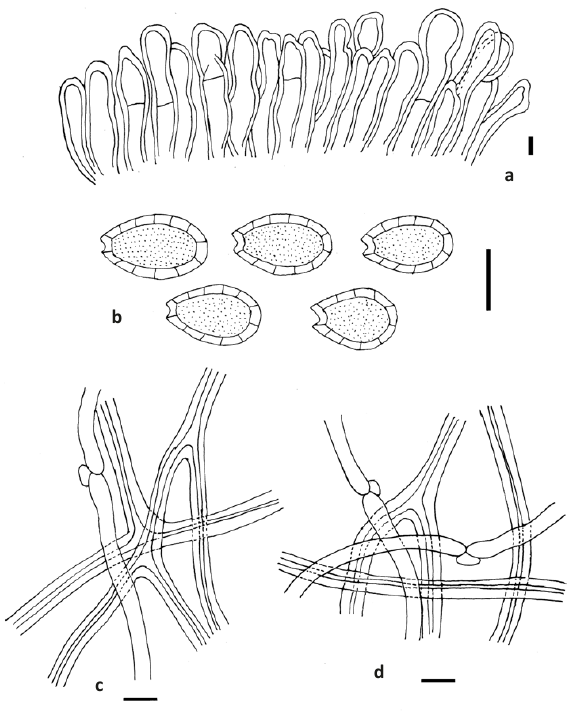
Figure 1. Ganoderma lucidum . a - hyphae of the cutis, b - basidiospores, c - context hyphae, d - tube layer hyphae. Bars = 5µm. Drawing by R.